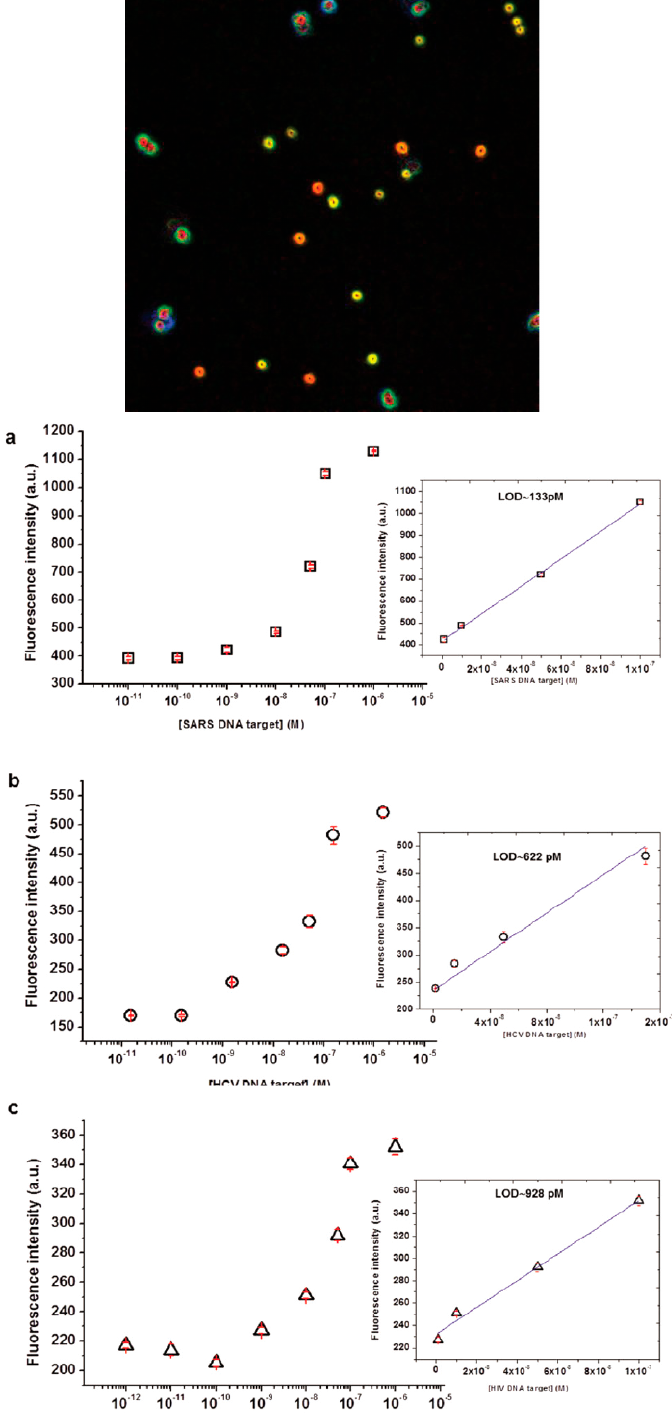
Figure 6. ( Upper ) Double encoded core/shell PEG microgels are imaged by fluorescence microscopy. Microgels are obtained by multistep synthesis allowing the realization of concentric shells with no spectral overlap between with the reporting system provided by suitable probe. ( Bottom ) The binding isotherms of ssDNA target of: ( a ) HIV; ( b ) SARS; and ( c ) HCV (Reproduced with permission from [55], copyright 2016 The Royal Society of Chemistry).